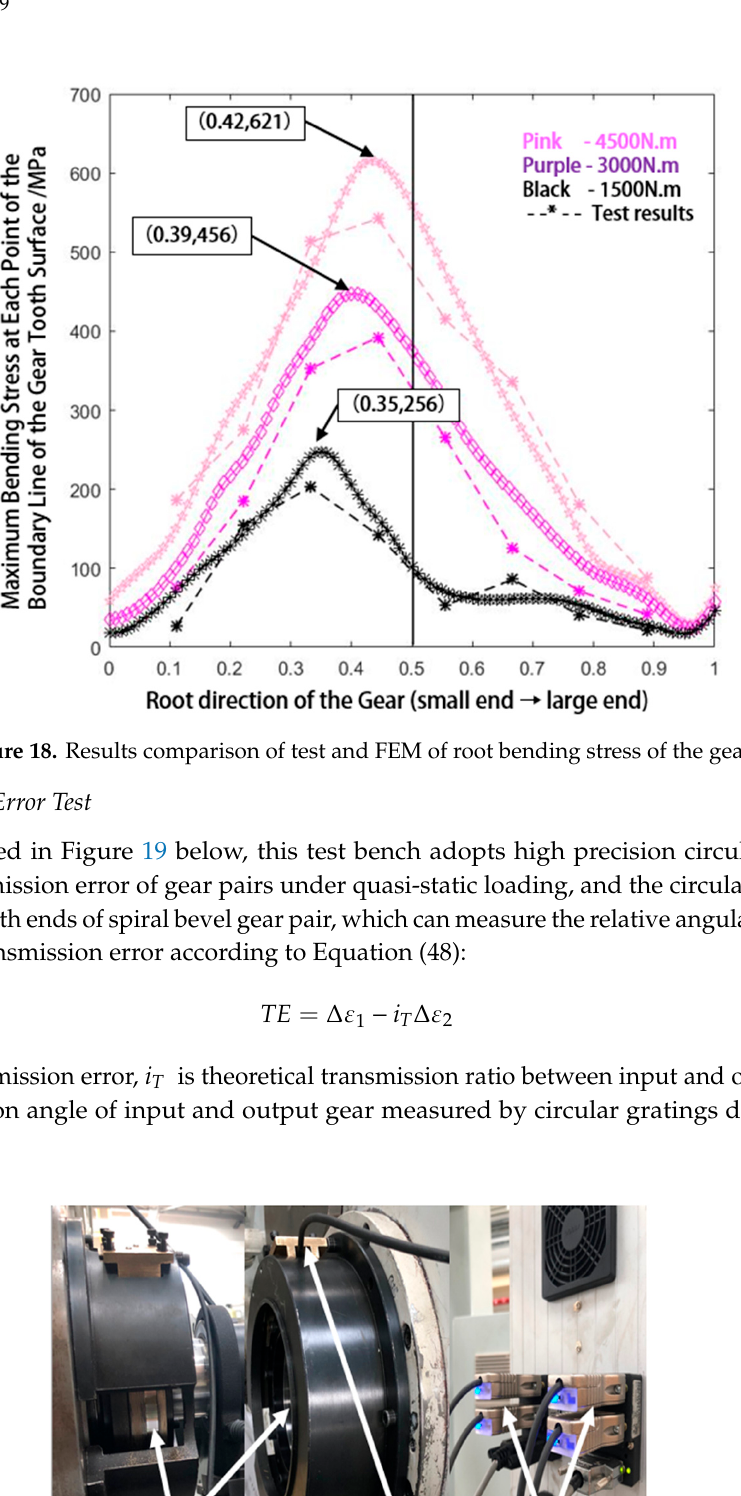
Figure 17. Layout of root strain gauges.